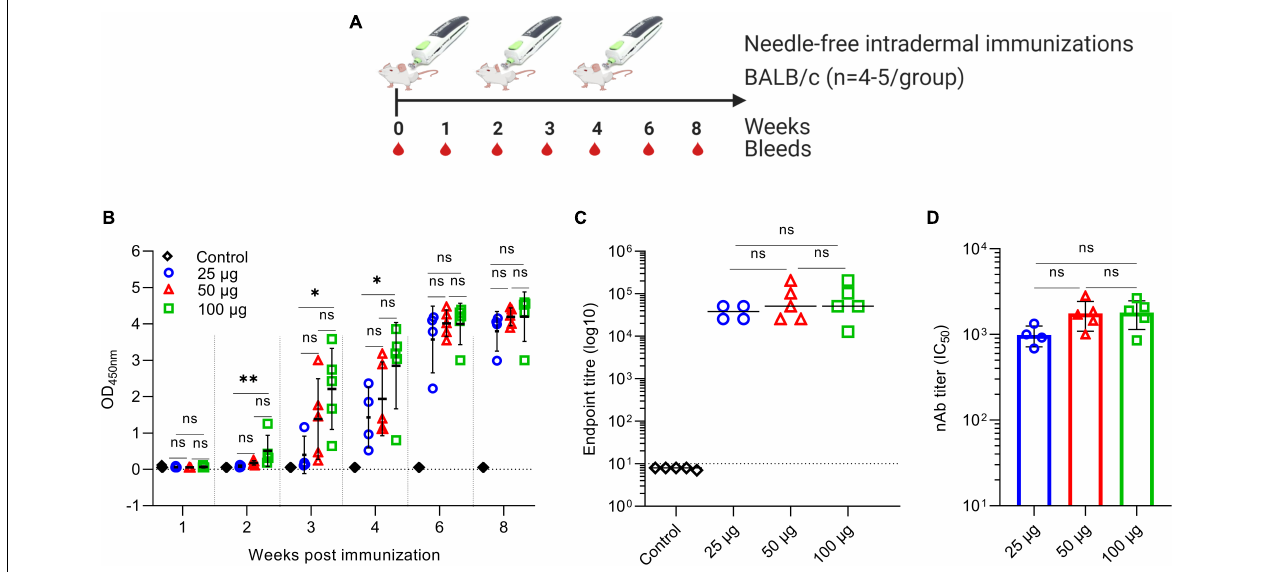
FIGURE 7 | Antibody response against SARS-CoV-2 in BALB/c mice intradermally immunized with VIU-1005 using a needle-free Tropis system. (A) Timeline of bleeding and immunization regimen. BALB/c mice were immunized intradermally with 3 doses of 25, 50, or 100 µ g at 2-week intervals using the VIU-1005 vaccine or control plasmid. (B) OD values of S1-specific binding total IgG at a 1:100 dilution from each mouse were determined by ELISA at 1, 2, 3, 4, 6, and 8 weeks post first immunization on day 0. (C) The end-point titer of S1-specific total IgG was determined by ELISA in samples collected from immunized mice at week 8. (D) nAb titers (IC 50 ) from mice immunized with doses of 25, 50, or 100 µ g of VIU-1005 plasmid using a needle-free system were determined at week 8. Data are shown as the mean ± SD from one experiment ( n = 4–5). Statistical significance was determined by one-way analysis of variance with Bonferroni post hoc test.